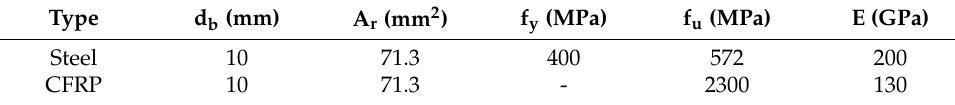
Table 3. Physical properties of